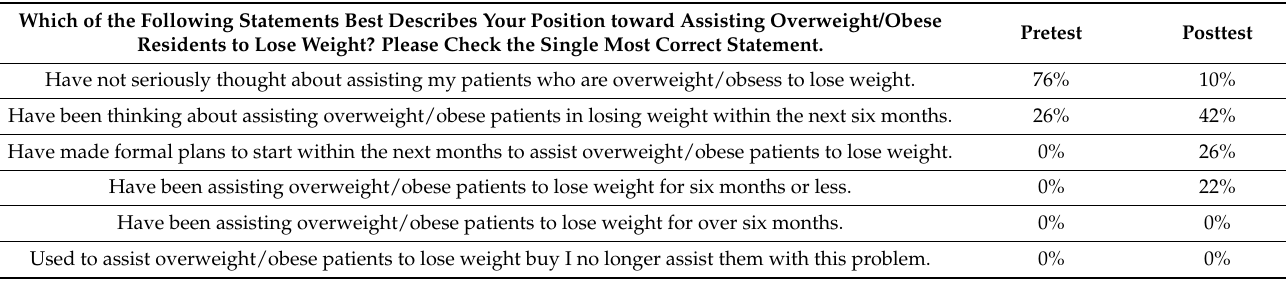
Table 2. Questionnaire Item 1 Response Frequency